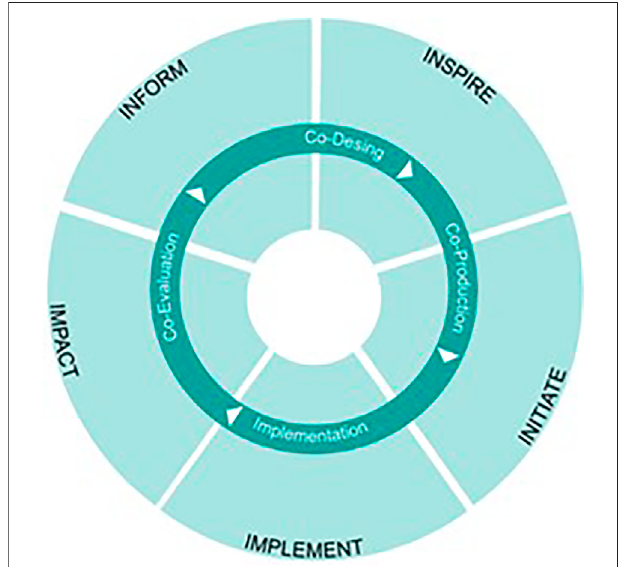
FIGURE 3 | Pillars for innovation